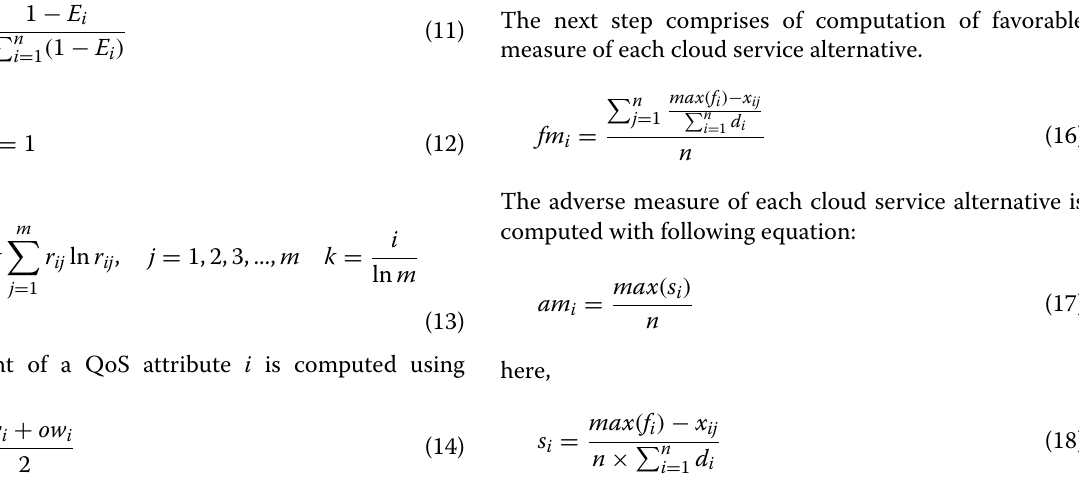
Table 6 Normalized Decision Matrix Cloud Services